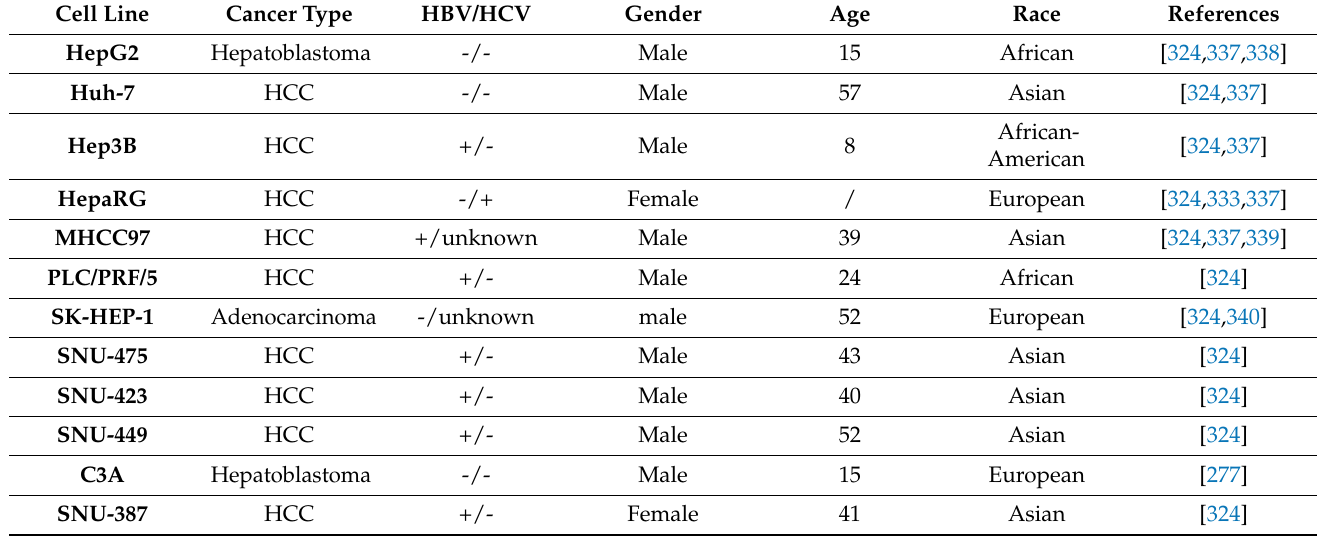
Table 8. Overview of commonly used human liver cancer cell